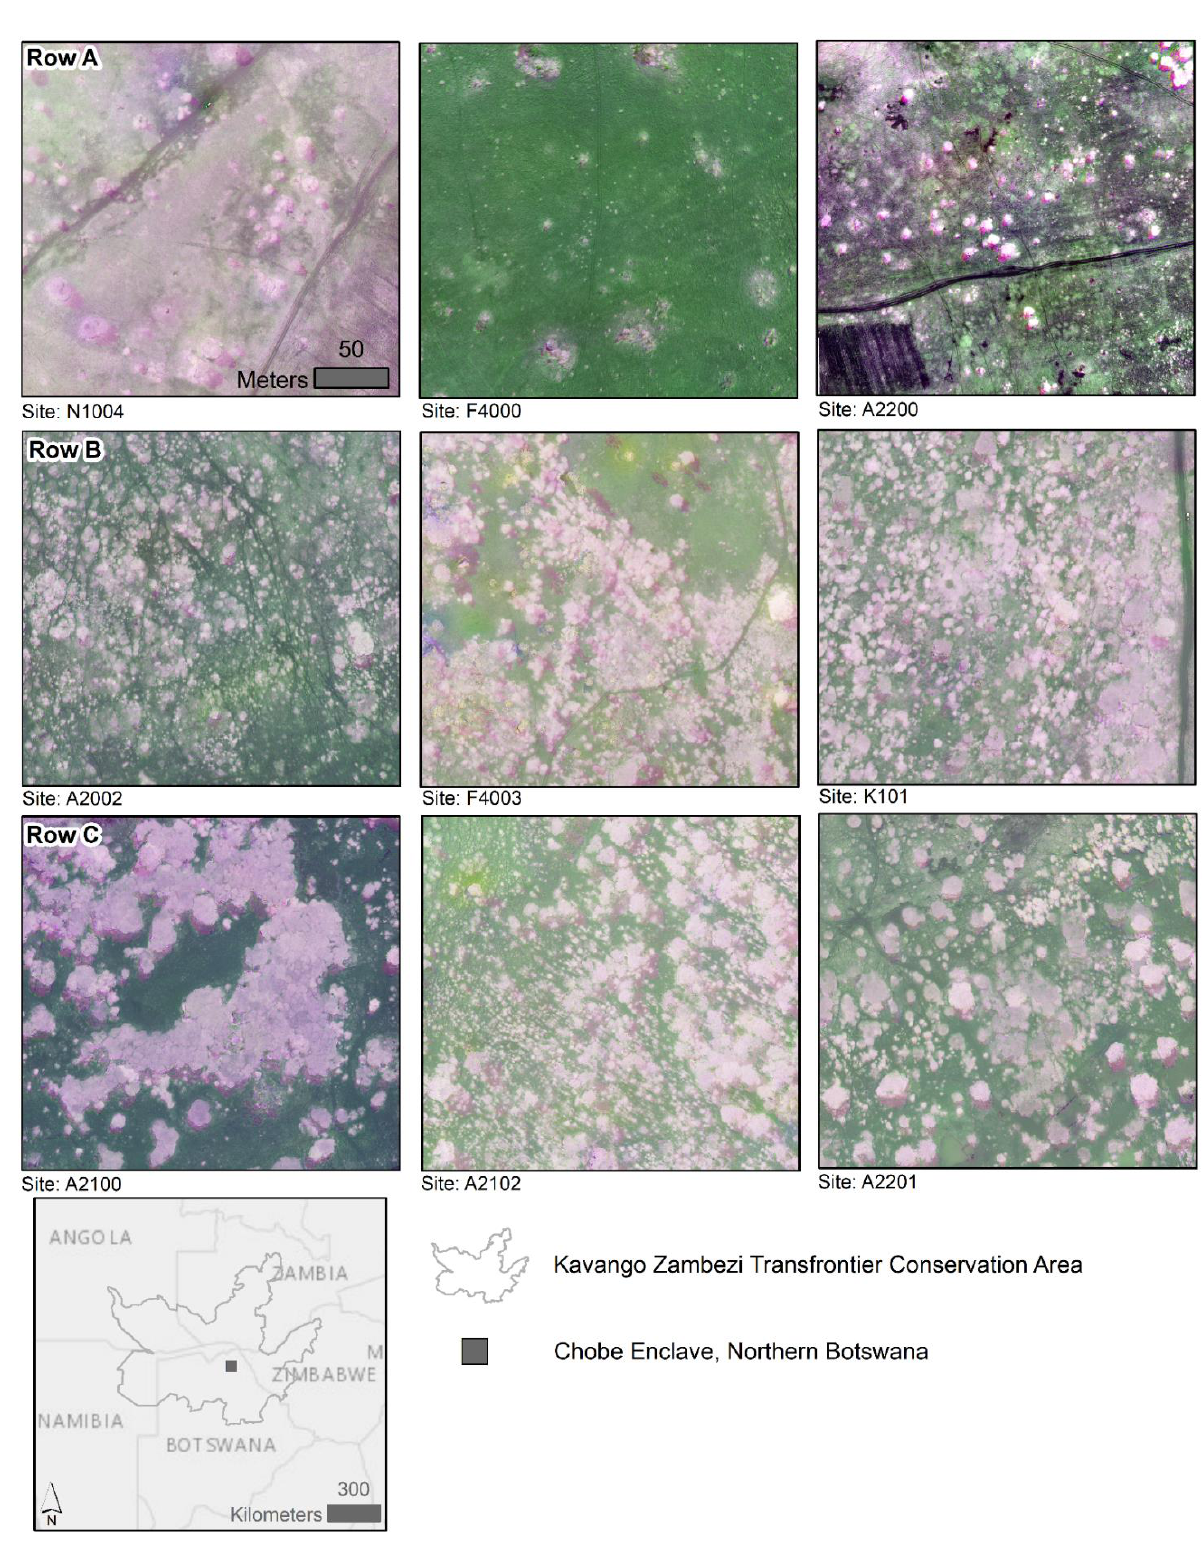
Figure 1. Individual sites ( N = 9) for UAS flights in the study area. RGB composites shown for the Sequoia sensor (red = NIR, green = visible green, blue = red edge) for ( Row A ) grass-, ( Row B ) shrub-, and ( Row C ) tree-dominated landscapes in the Chobe Enclave of northern Botswana.